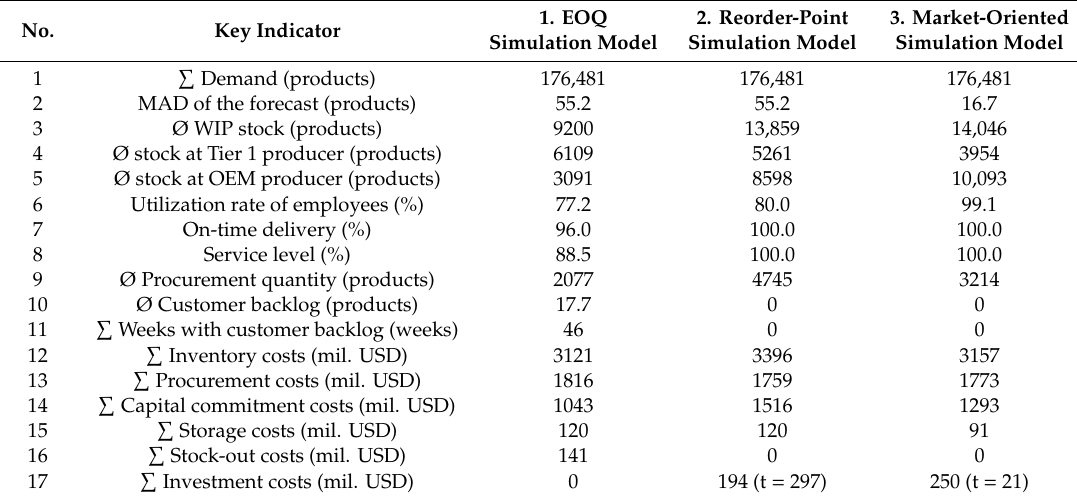
Table 11. Simulation results for the third demand